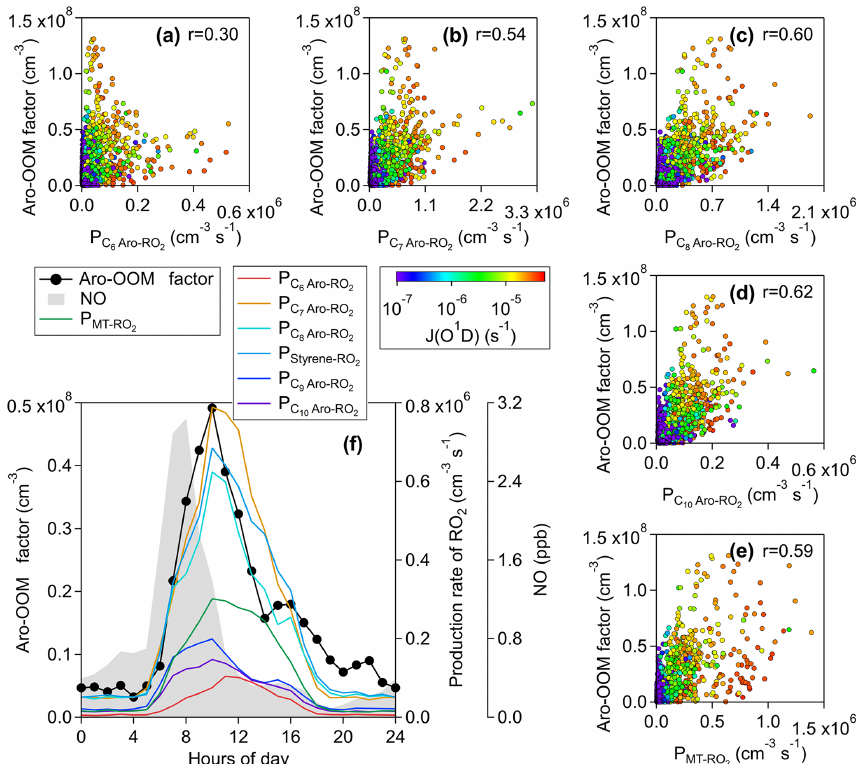
Figure 4. Correlations of the Aro-OOM-dominated factor with the production rate of RO 2 from OH-initiated oxidation of (a) ben- zene ( P C ), (b) toluene ( P C ), (c) C 8 aromatics ( P C ), (d) C 10 aromatics ( P C ), and (e) monoterpenes 7 Aro-RO 2 6 Aro-RO 2 8 Aro-RO 2 10 Aro-RO 2 ( P MT-RO ). All the dots are colored by J( O 1 D ) to show the difference between day and night. The median diurnal patterns of this factor and 2 related parameters are plotted in (f)